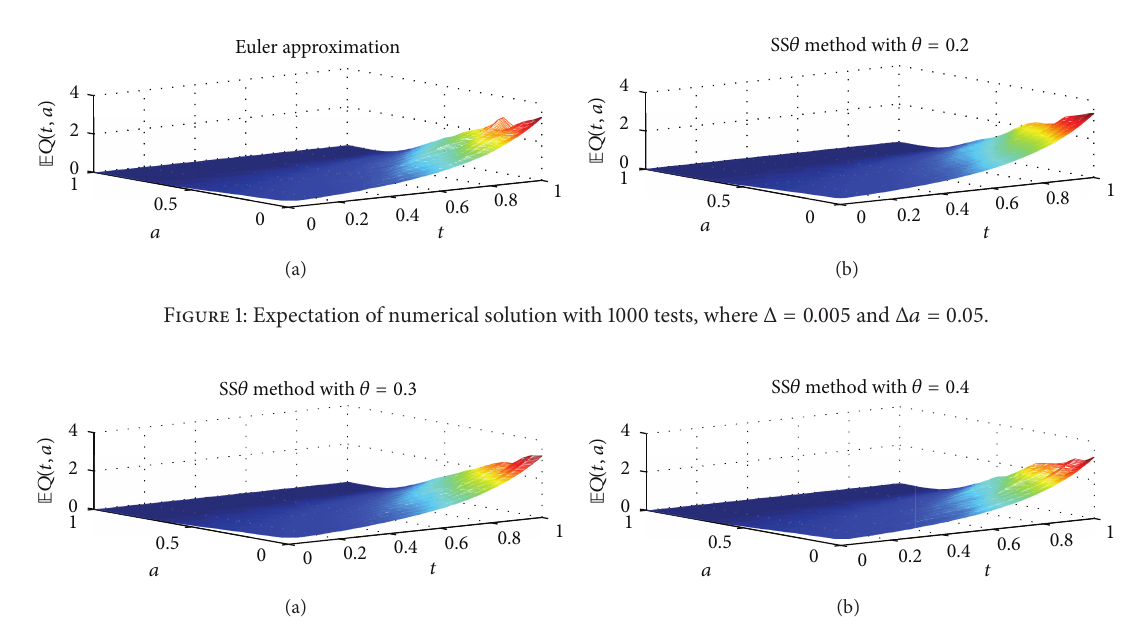
Figure 2: Expectation of numerical solution with 1000 tests, where Δ = 0.005 and Δ𝑎 = 0.05